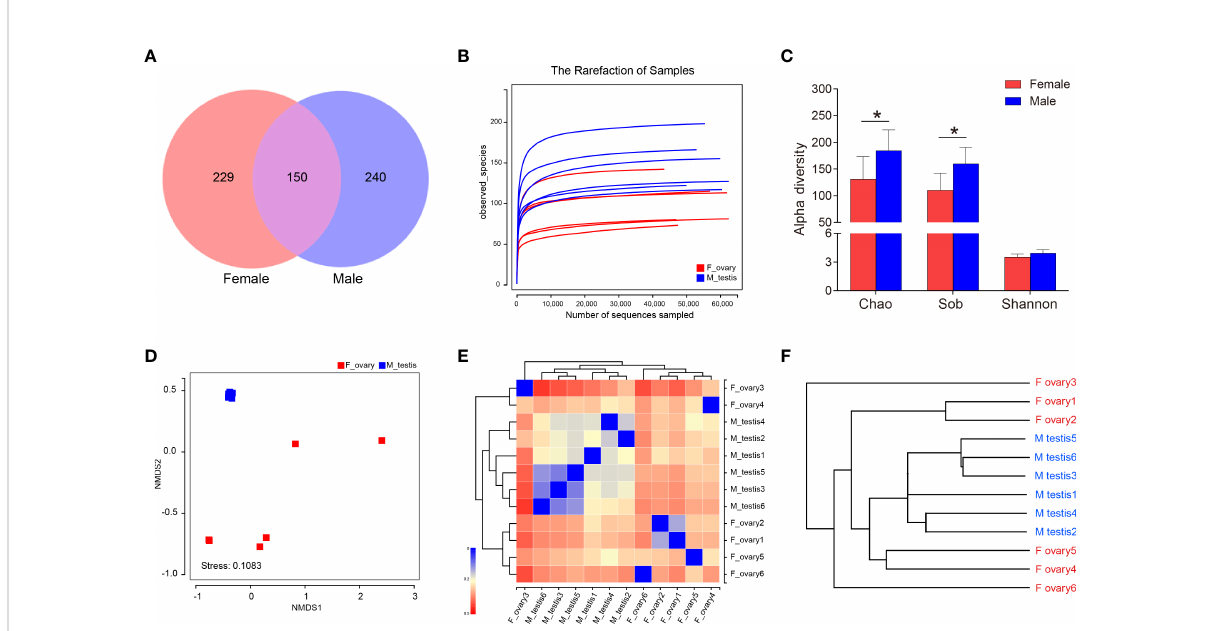
FIGURE 3 Diversity analysis in M. albus . (A) Venn diagram displays the number of shared and unique OTUs in the gonads of female and male M. albus . (B) Rarefaction analysis of female and male gonads. (C) Histograms represent alpha diversity analyses in the gonads of male and female gonads M. albus, including Chao, Sob, and Shannon indices. (D) NMDS shows the relationship between females and males. (E) heat map analysis shows the relationship among female and male samples. (F) Hierarchical cluster analysis of weighted-unifrac distances generated from ovary and testis